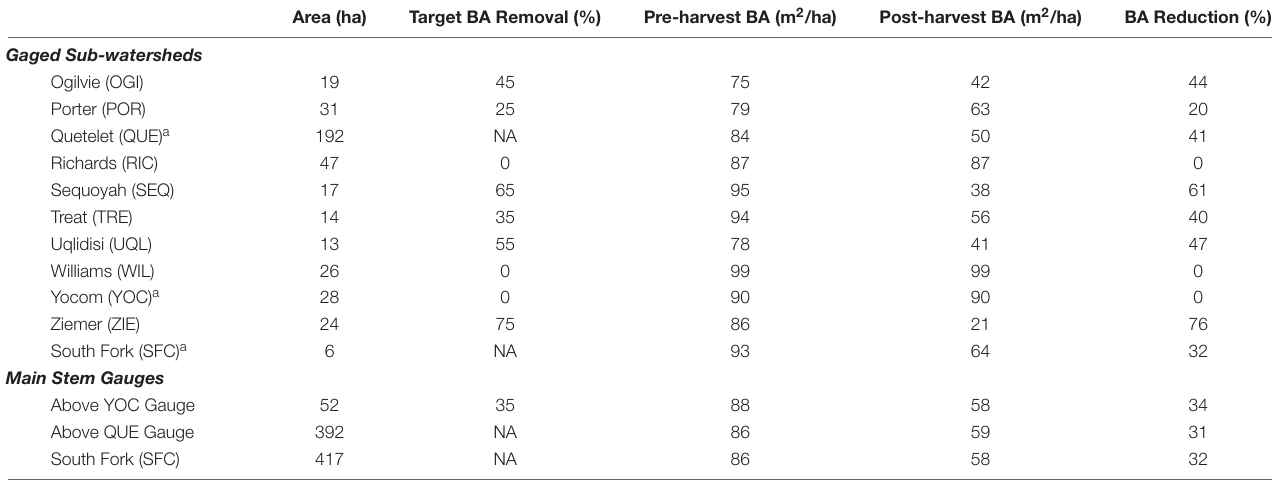
TABLE 3 | Sub-watershed and SFC areas, treatment target basal area (BA) reduction rates, pre- and post-harvest basal areas, and area-weighted percent basal area